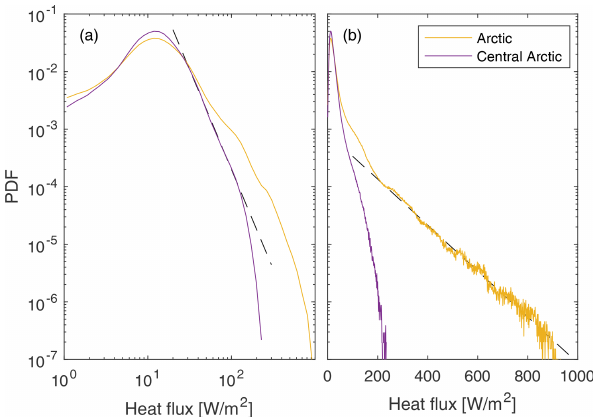
Figure 4. The probability density function of modelled atmospheric heat flux in the Arctic and Central Arctic regions over JFM. The dashed lines are linear fits discussed in the text.